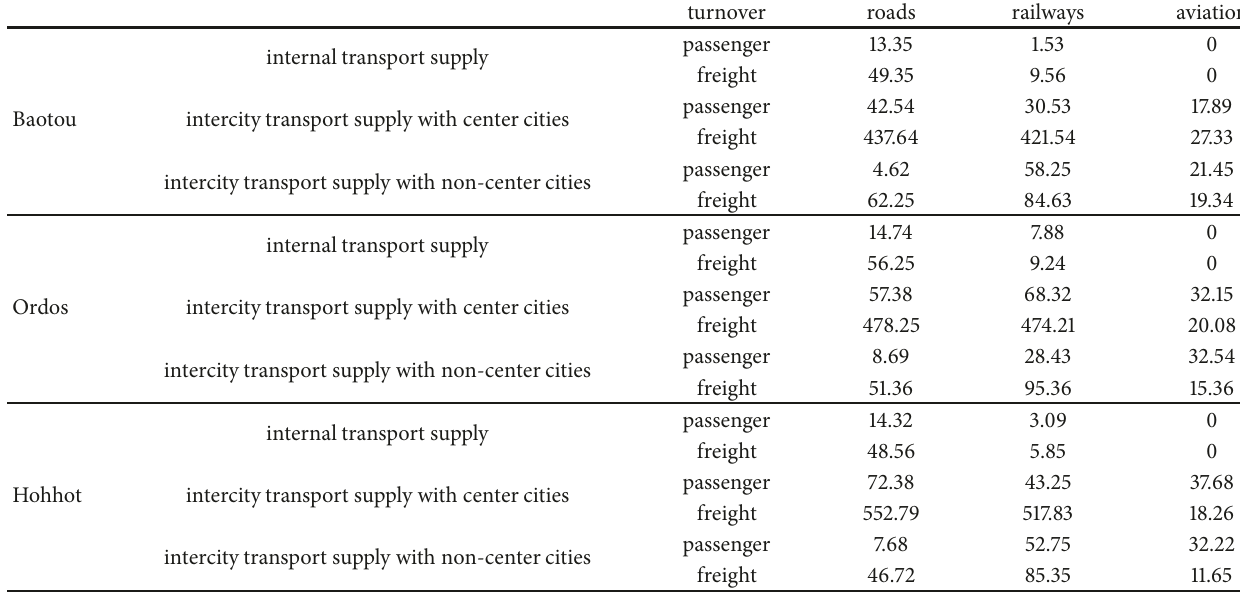
Table 6: Turnover of passenger and freight of HuBaoOr urban agglomeration in 2015.